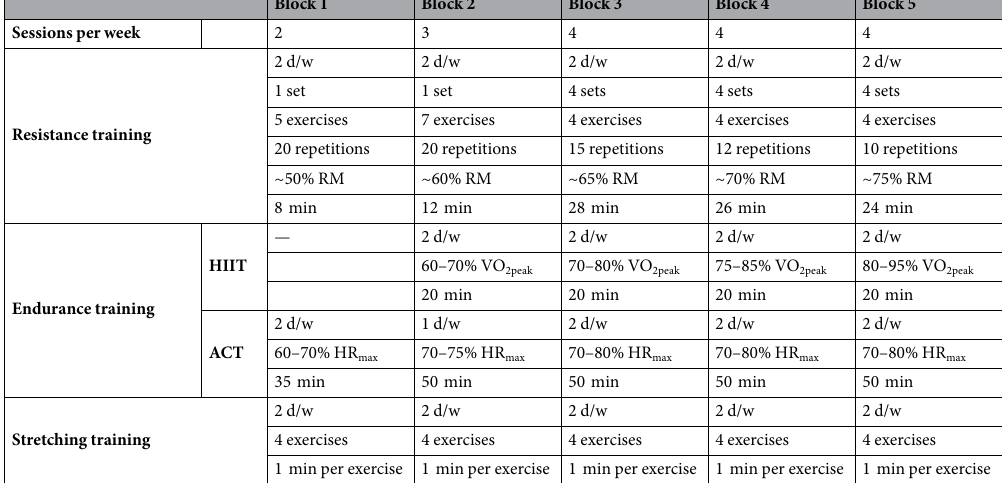
Table 4. Exercise program performed by the experimental group. d/w indicates days per week; RM, repetition maximum; ACT, aerobic continuous training; HR max , maximal heart rate; HIIT, high intensity interval training; VO 2peak , peak oxygen uptake. Blocks 1 and 2 were considered as a progressive adaptation. During the second half of block 3, the participants were evaluated and the new values of RM and VO 2peak were used to prescribe the exercise intensity from that moment on. HIIT, resistance training and stretching were combined in the same session. Therefore, independently of its modality (concurrent vs aerobic continuous exercise), every session had a similar duration ( ≈ 50